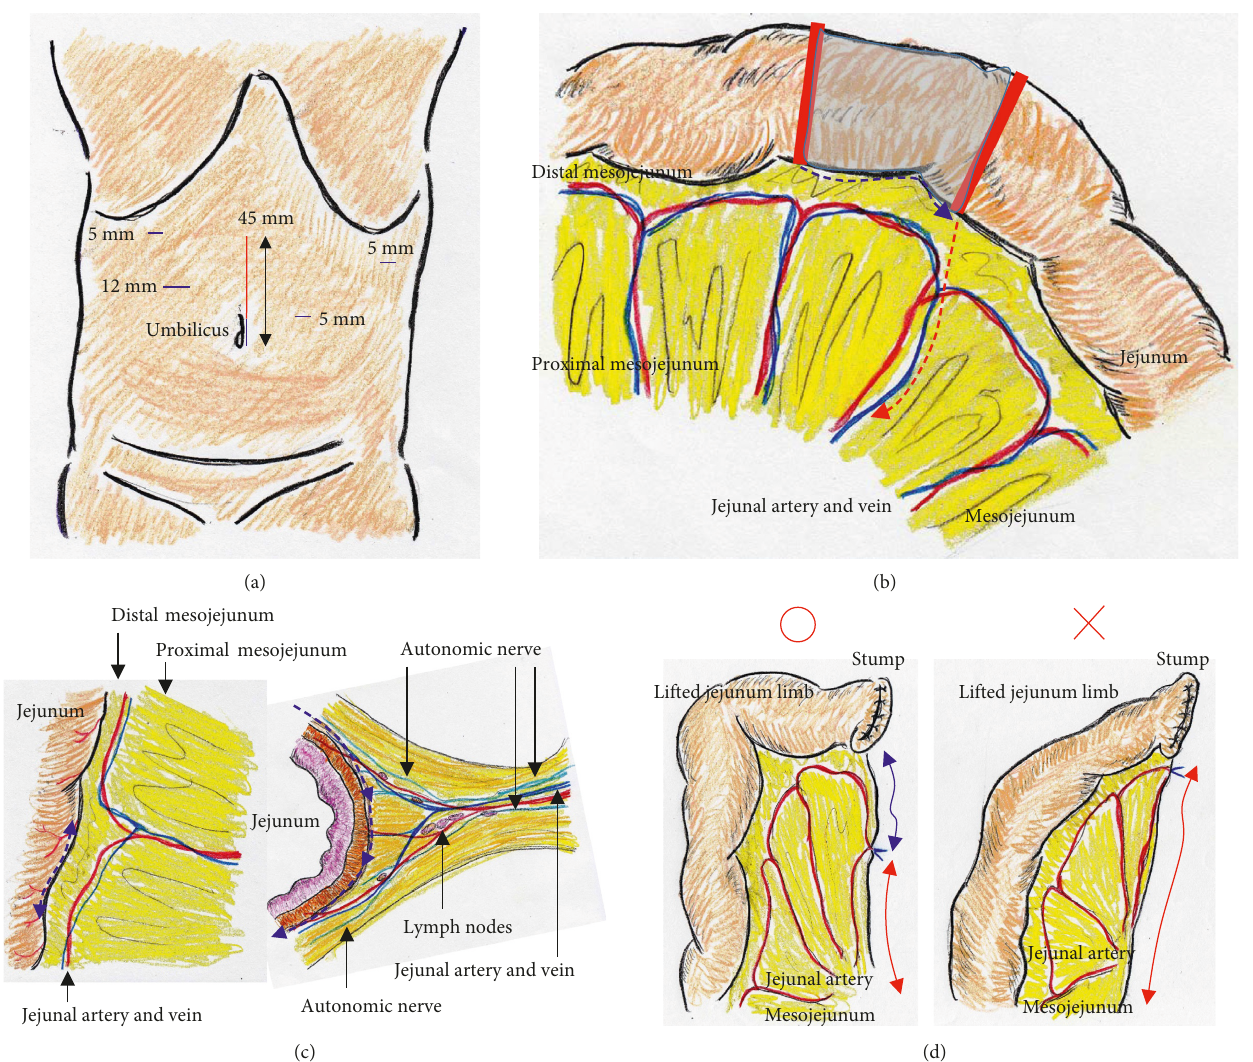
Figure 1: (a) Camera port positioned via the umbilicus; a total of five ports (blue lines) were placed. A 45 mm long incision extending from the umbilicus (red line) was made. (b) Approximately 20cm of jejunum was sacrificed (shaded area), with the sacrificed length decided based on the segment’s jejunal vessels (red solid lines). The jejunum was sacrificed (blue dotted line), and then, the mesojejunum was transected to lift the jejunal limb (red dotted line). (c) To preserve the distal mesojejunal autonomic nerves, the jejunum was sacrificed as close to the jejunal wall as possible (blue dotted line). Branches from the marginal vessels were carefully sealed in three groups using an advanced energy device to prevent both unexpected shortening of the mesojejunum and thermal nerve damage (blue dotted lines). (d) The sacrificed jejunum contributed well to ideal mesojejunal margins in the lifted jejunal limb (blue arrow). The jejunal limb could be lifted with no tension on the retracted mesojejunum (red